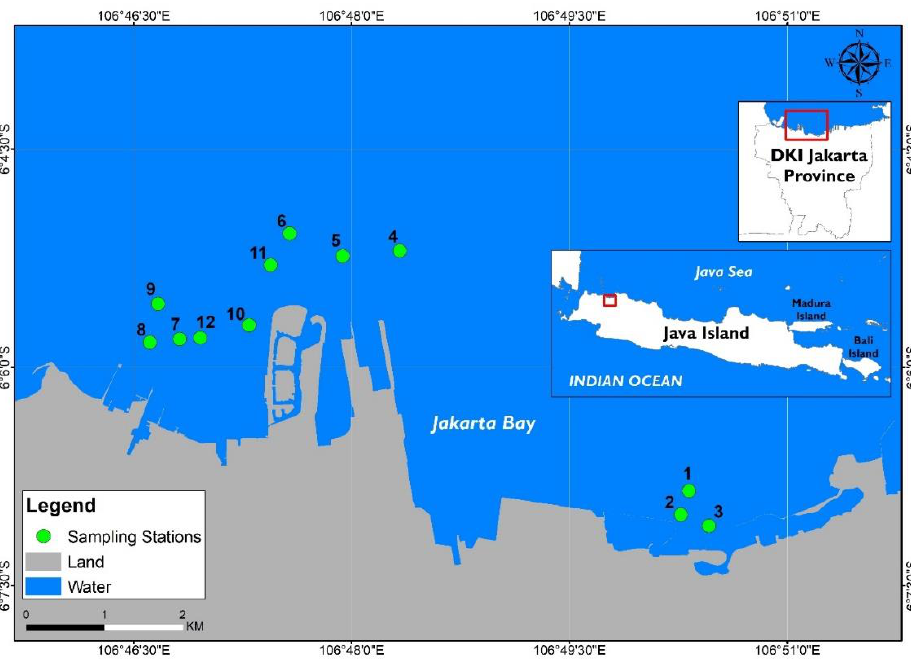
Fig. 1: Geographic location of the study area and sampling stations in Jakarta Bay, Indonesia